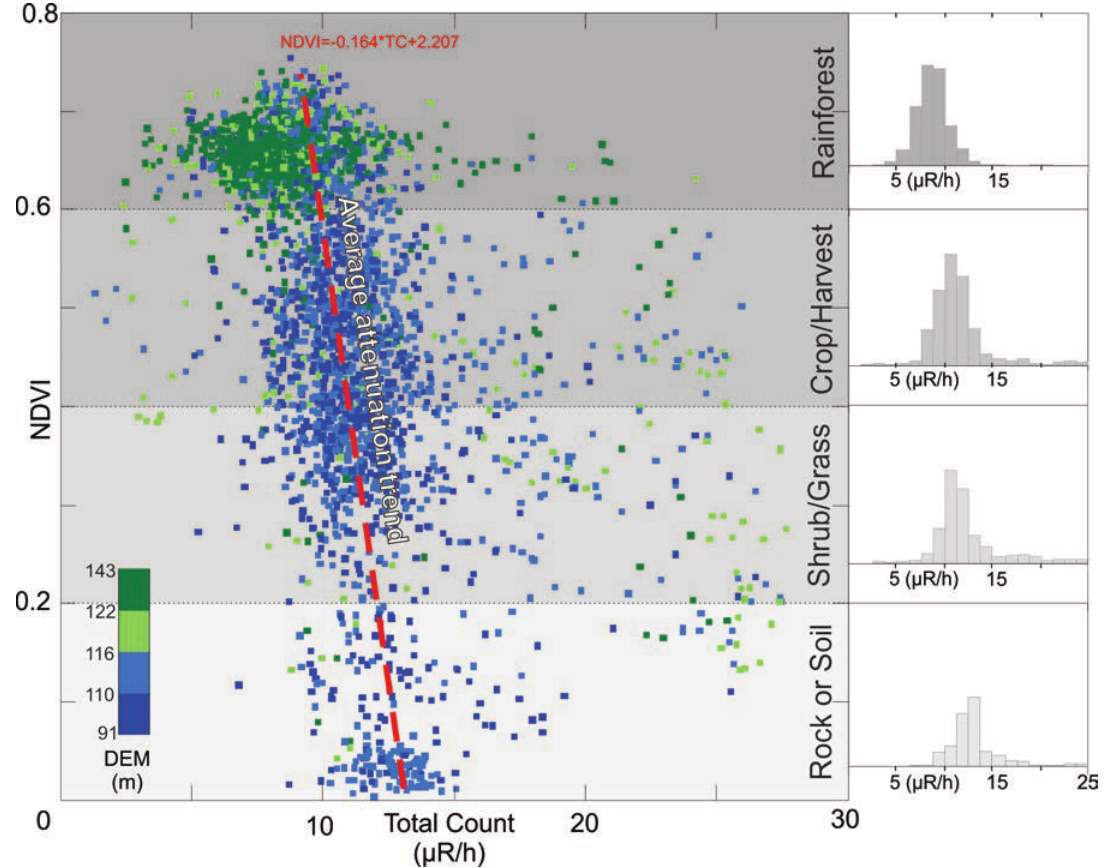
Figure 8 - Total Count (µR/h) scatter plot from NDVI. The dots are colored according to the elevation obtained in the airborne DEM (see the legend). The NDVI intervals are divided by the correspondent vegetation classes. It is possible to notice an attenuation average trend from the rainforest to the soil samples. Most of the DEM highest values are concentrated above the NDVI 0.6 line. To the right, the histograms of each interval for TC values are